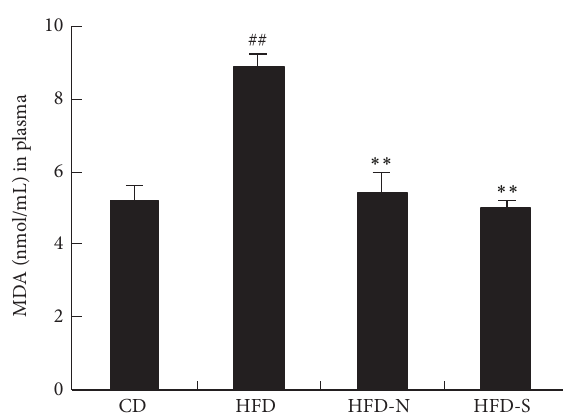
Figure 3: Niacin and simvastatin decreased the level of plasma MDA in guinea pigs after treatment for 8 weeks. MDA was determined by a spectrophotometric measurement of thiobarbituric acid-reactive substances (TBARS) according to the manufacturer’s instruction. Data are presented as mean ± SD ( 𝑛 = 8 ). ## 𝑃 < 0.01 versus CD group; ∗∗ 𝑃 < 0.01 versus HFD